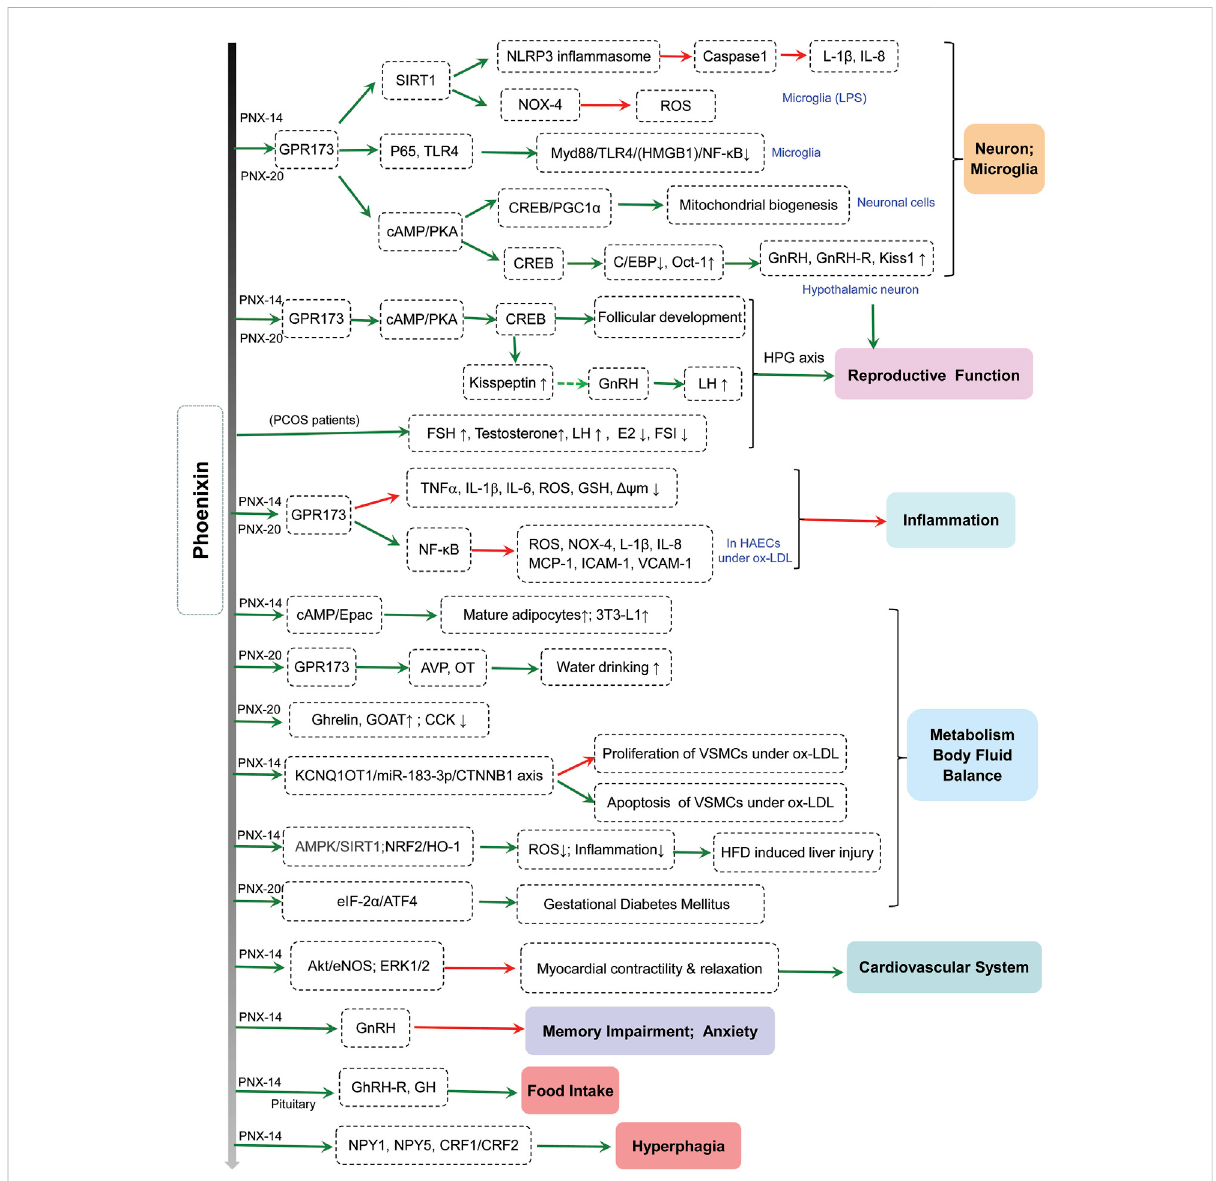
The physiological and pathological roles of phoenixin. AHA, Anterior hypothalamic area; Akt, protein kinase B; AMPK, AMP-activated protein kinase;ATF4,activatingtranscriptionfactor4;AVP,argininevasopressin;cAMP,cyclicadenosinemonophosphate;C/EBP,CCAAT/enhancerbinding protein; CREB, cAMP-response element binding protein; CRF1/CRF2, corticotropin-releasing factor1/2;CCK, cholecystokinin; E2, estradiol; eIF-2 α , eukaryotic translation initiation factor 2 α ; eNOS, endothelial nitric oxide synthase; ERK, extracellular signal-related kinase; FSH, follicle- stimulating hormone; FSI, fasting serum insulin; GH, growth hormone; GhRH-R, growth hormone-releasing hormone receptor; GnRH, gonadotropin-releasing hormone; GnRH-R, gonadotropin-releasing hormone receptor; GOAT, ghrelin-O-acyl transferase; HAECs, human aortic endothelial cells; HFD, high-fat diet; HMGB1, highmobilitygroup box1;HO-1, heme oxygenase-1; ICAM-1, intercellularadhesionmolecule-1;IL-1 β , interleukin-1 β ; IL-8, interleukin-8; LH, luteinizing hormone; LPS, lipopolysaccharide; MCP-1, monocyte chemotactic protein-1; Myd88, myeloid differentiation primary response 88; NF- κ B, nuclear factor- κ B; NLRP3, NOD-like receptor protein3; NOX-4, NADPH oxidase 4;NPY1, neuropeptide Y1; NPY5, neuropeptide Y5; NRF2, Erythroid 2-related factor 2; NST, nucleus of the solitary tract; Oct-1, octamer-binding transcriptionfactor-1;OT, oxytocin; ox-LDL, oxidized low-density lipoprotein; PCOS, polycystic ovary syndrome; PKA, protein kinase A; PGC-1 α , peroxisome-proliferator- activated receptor coactivator (PGC)-1 α ; ROS, reactive oxygen species; SIRT1, Sirtuin1; TLR4, toll-like receptor 4; VCAM-1, vascular cell adhesion molecule-1; VSMCs, vascular smooth muscle cells; Δψ m; mitochondrial membrane